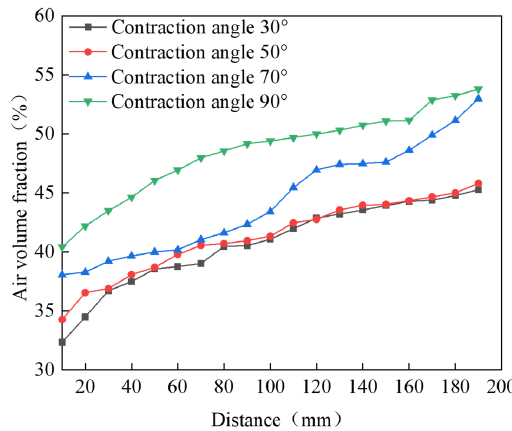
Figure 13. Effect of contraction angle on air volume fraction.